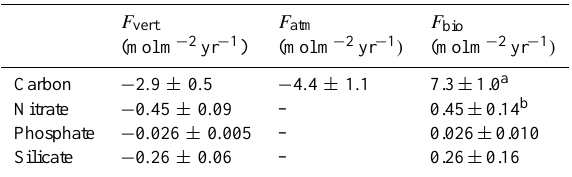
Table 2. Summary of annual fluxes (molm − 2 yr − 1 ) of carbon, ni- trate, phosphate, and silicate to the surface layer (upper 100m) of the Iceland Sea; vertical flux ( F vert ), air–sea flux ( F atm ), and bio- logical production ( F bio ). Negative values indicate a flux into the surface layer. The horizontal fluxes are assumed to balance over the year and were set to zero. F vert F atm F bio (molm − 2 yr − 1 )